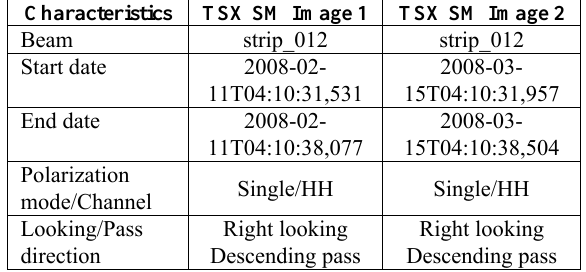
Figure 4. TSX HS Istanbul SAR image-pair Table 1. Characteristics of TSX SM Istanbul SAR